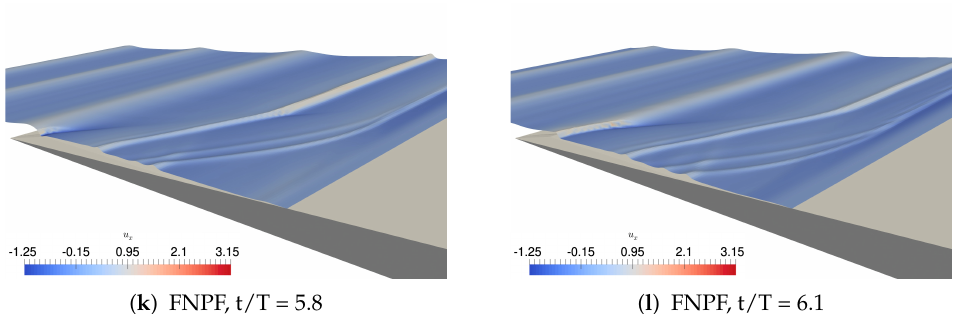
Figure 11. Free surface elevations with velocity contours at different time steps for three-dimensional wave breaking on a reef calculated using CFD and SFLOW.